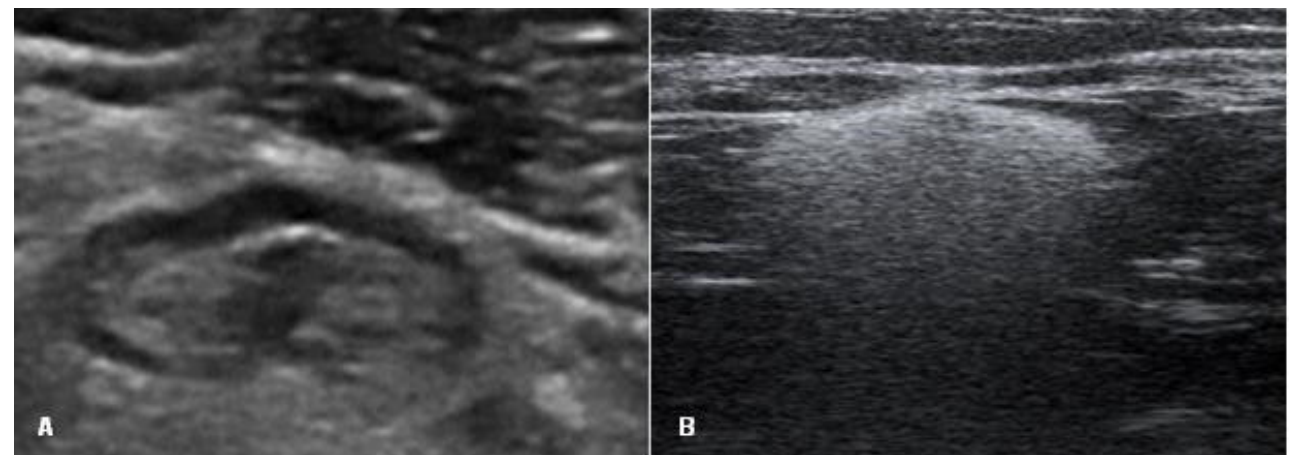
Figure 3. Signs of an axillary lymph node on ultrasound: ( A ) lymph node with normal appearance (oval shape, smooth cortex, unchanged, clearly visible fat gate) and ( B ) lymph node with silicone (a sharp upper border and sides and the loss of the lower border due to the ‘‘snowstorm’’ artifact).